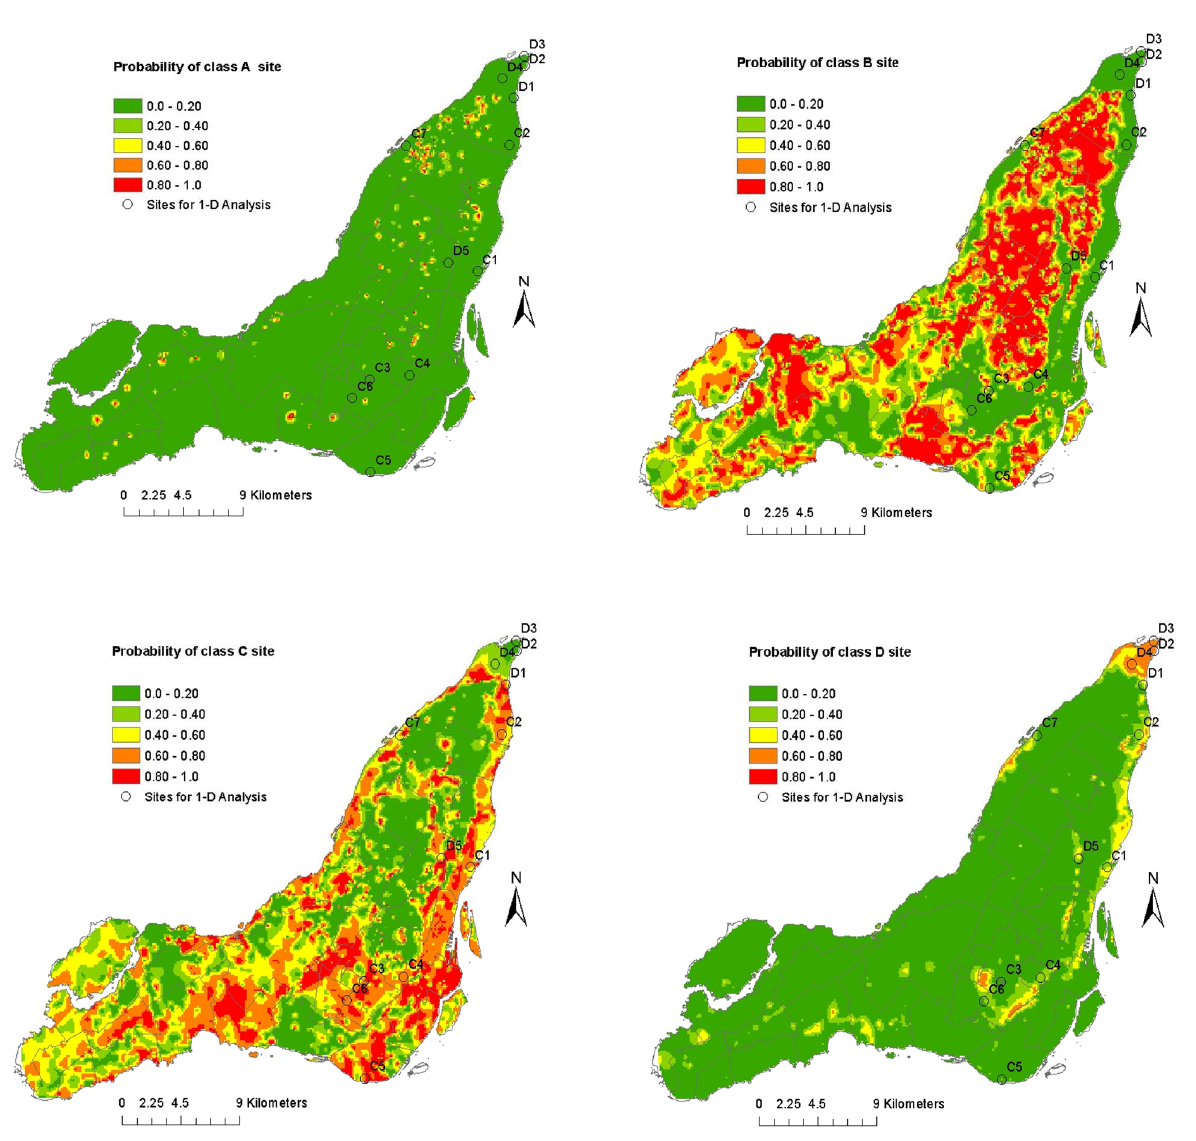
Figure 3. Locations of the 12 representative sites on the probabilistic microzonation maps derived from the method proposed by Talukder and Chouinard [35] for site classes A, B, C and D.